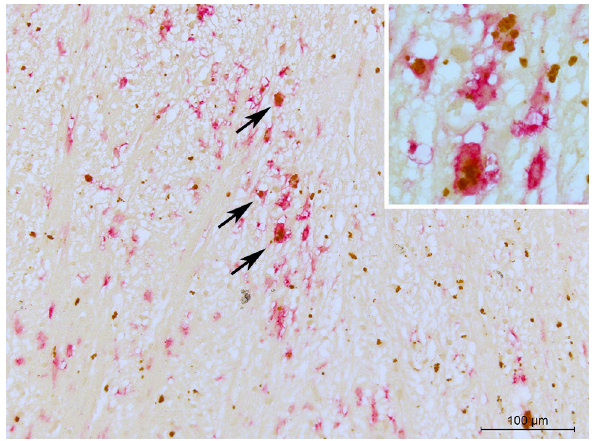
Figure 4. Double staining of lesion for identification of LGMN positive cells. (LGMN (DAB, brown) in HLA-DR (Alkaline phosphatase, reddish pink) positive cells (arrows), × 20 magnification and insert at × 63